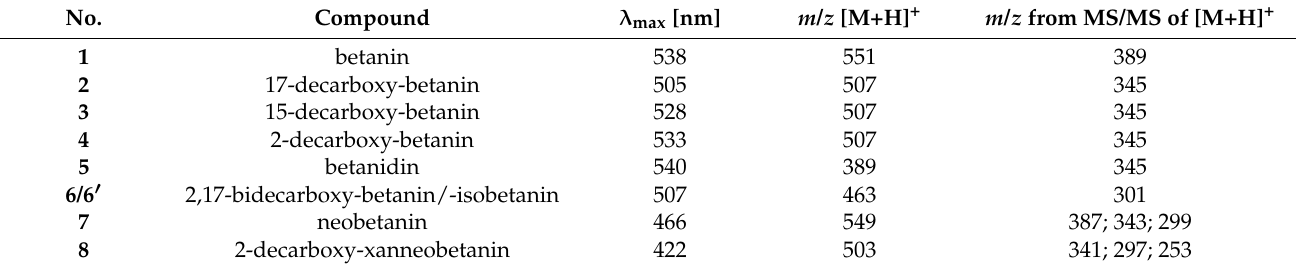
Table 1. Spectrophotometric and low-resolution mass spectrometric data of the studied betanidin, betanin, and its derivatives for their anti-hypochlorite activity. For the chromatographic profile of the pigments in the BRE, refer to a previous study [17].